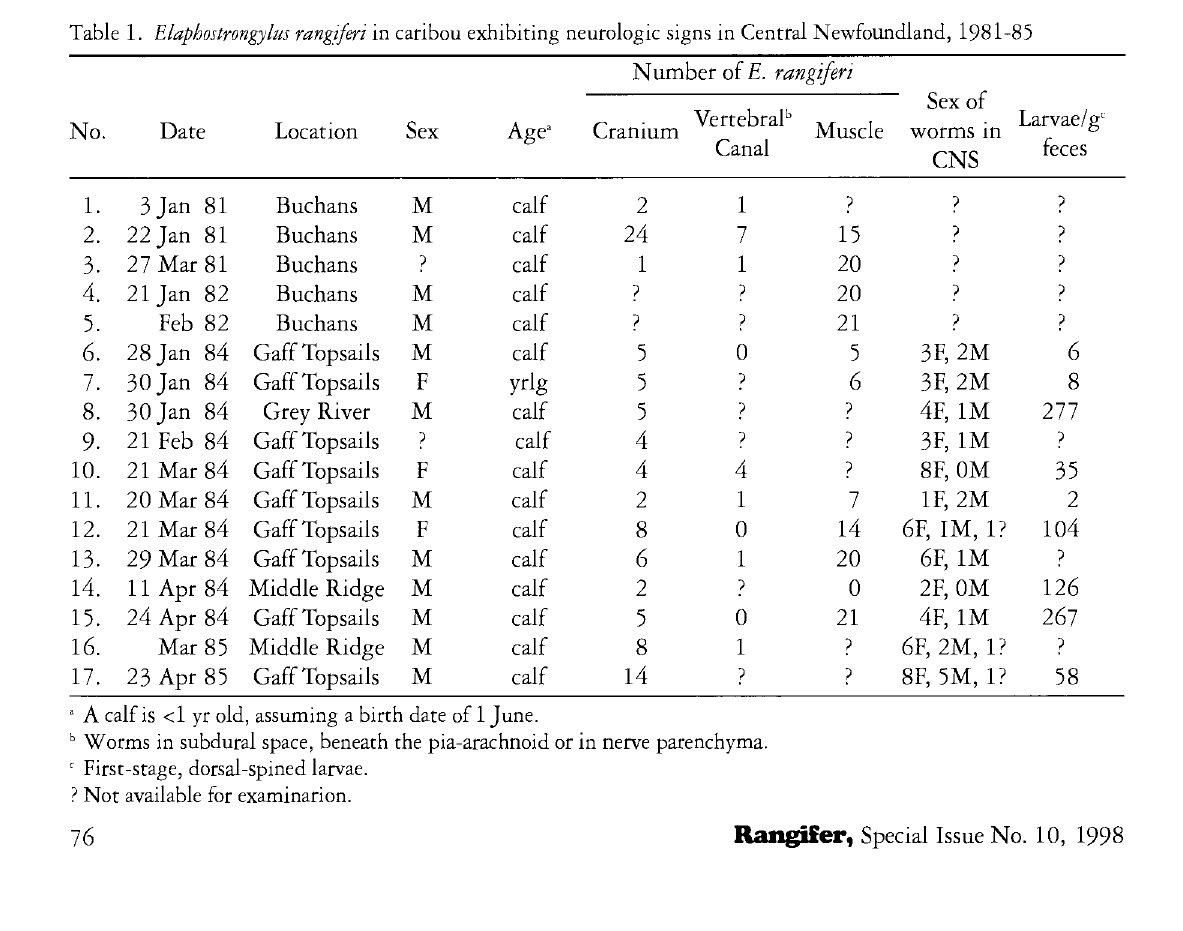
Table 1. Elaphostrongylus rangiferi in caribou exhibiting neurologic signs in Central Newfoundland,